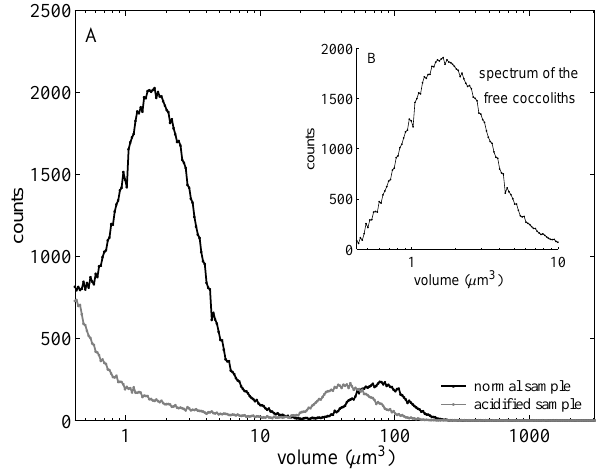
Fig. 1. Multisizer ™ 3 volume spectra. (A) Spectra of the E. huxleyi population (black line) and after treatment with HCl (grey line). ™ 3 volume spectra. (A) Spectra of the E.huxleyi population (black line) and after Fig. 1. Multisizer (B) Volume spectrum of the free coccoliths after subtracting the treatment with HCl (grey line). (B) Volume spectrum of the free coccoliths after subtracting the acidified sample from the normal acidified sample from the normal sample.